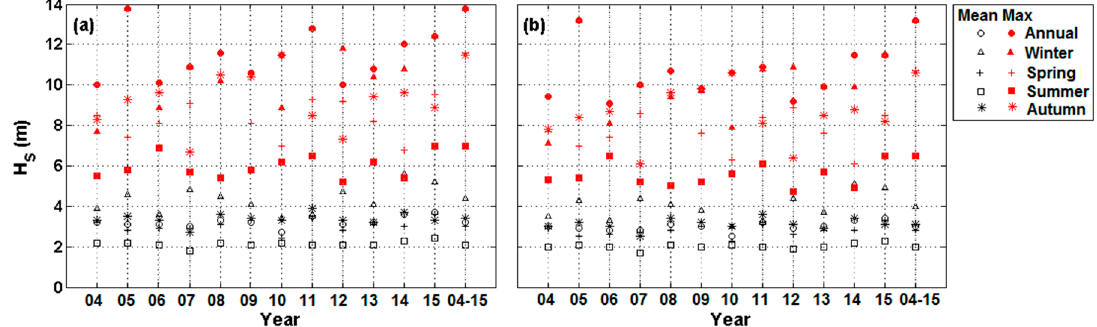
Figure 7. Summary statistics from annual and seasonal analyses of H s (m) for mean and maximum ( Max ) at ( a ) BA and ( b ) BB.